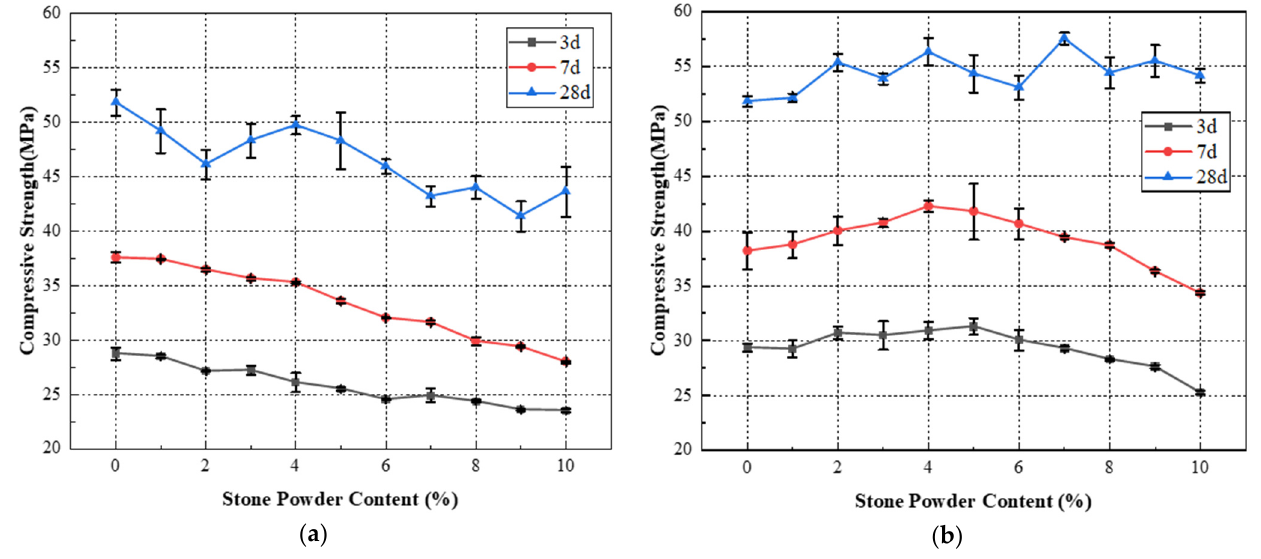
Figure 5. Compressive strength of mortar versus stone powder content curve: ( a ) standard sand; ( b ) machine-made